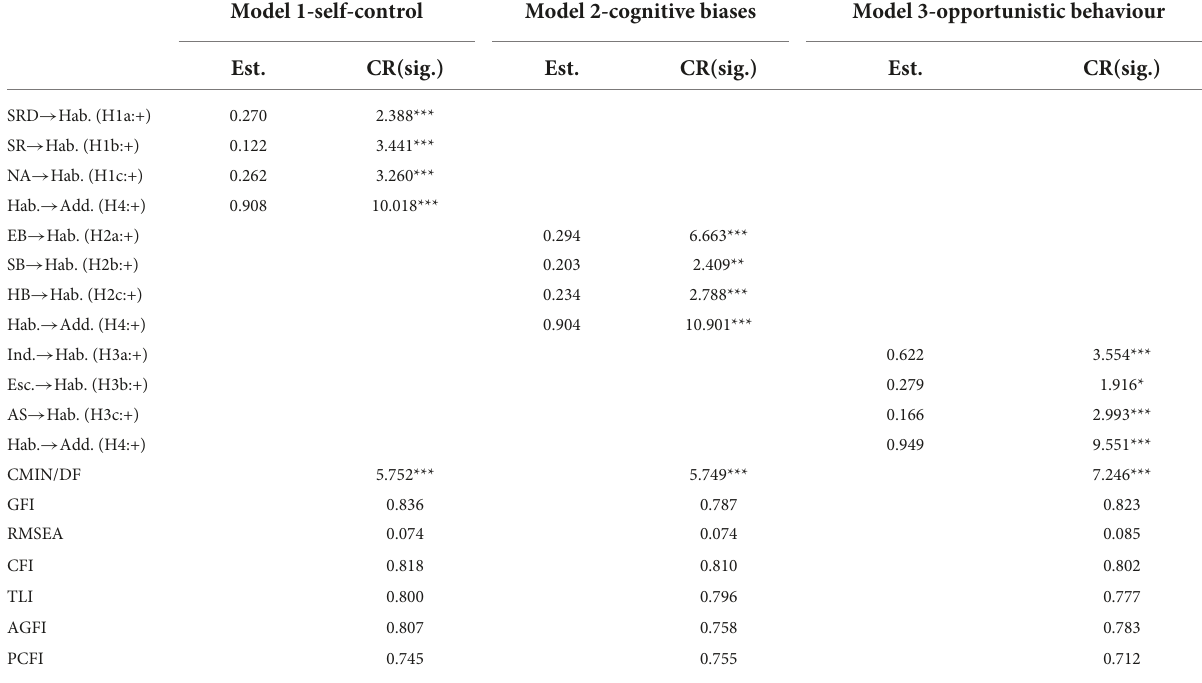
TABLE 4 Hypotheses results in each